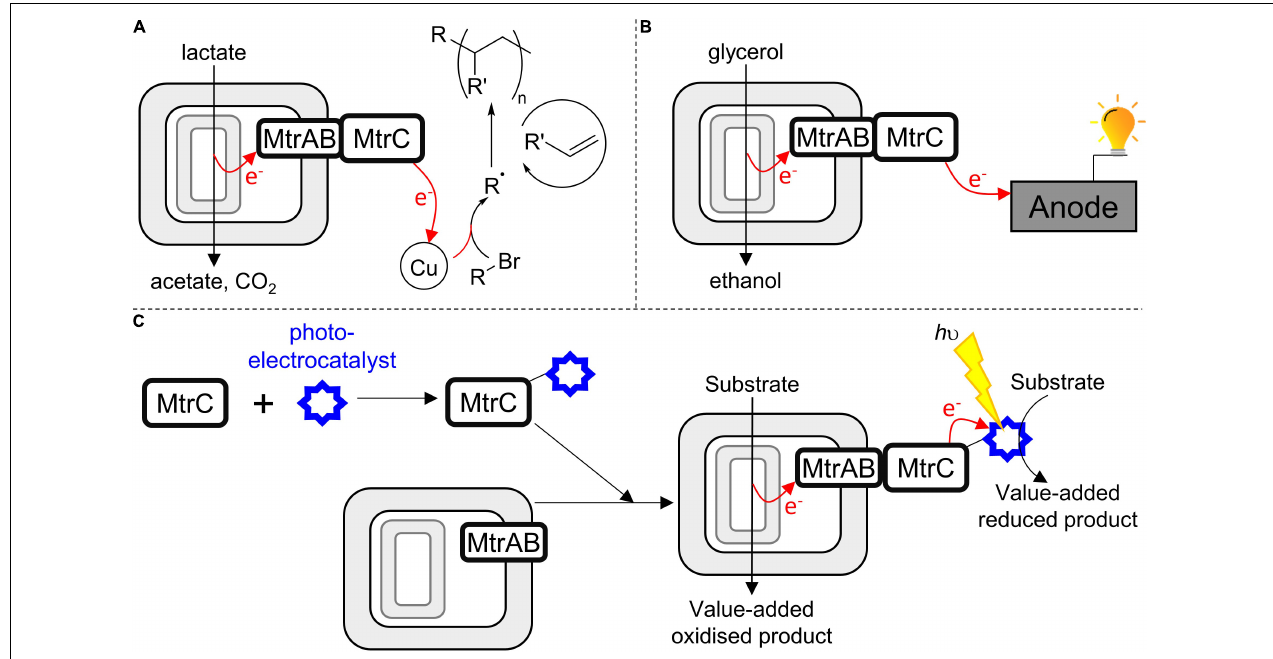
FIGURE 8 | Harnessing the MTR complex to couple internal (biological) and external (synthetic) catalysts in a closed redox cycle. (A) S. oneidensis as a living electrode driving an exogenous copper-based catalyst to produce radicals, these initiate olefin polymerization (Fan et al., 2018). (B) S. oneidensis performing electrode-assisted glycerol oxidation (Flynn et al., 2010). (C) A strategy to engineer bacteria for semiartificial photosynthesis motivated by this work; soluble MtrC is functionalized with a photoelectrocatalyst and then assembles spontaneously with bacteria presenting MtrAB in their outer membrane; allowing intracellular substrate oxidation to be coupled to extracellular